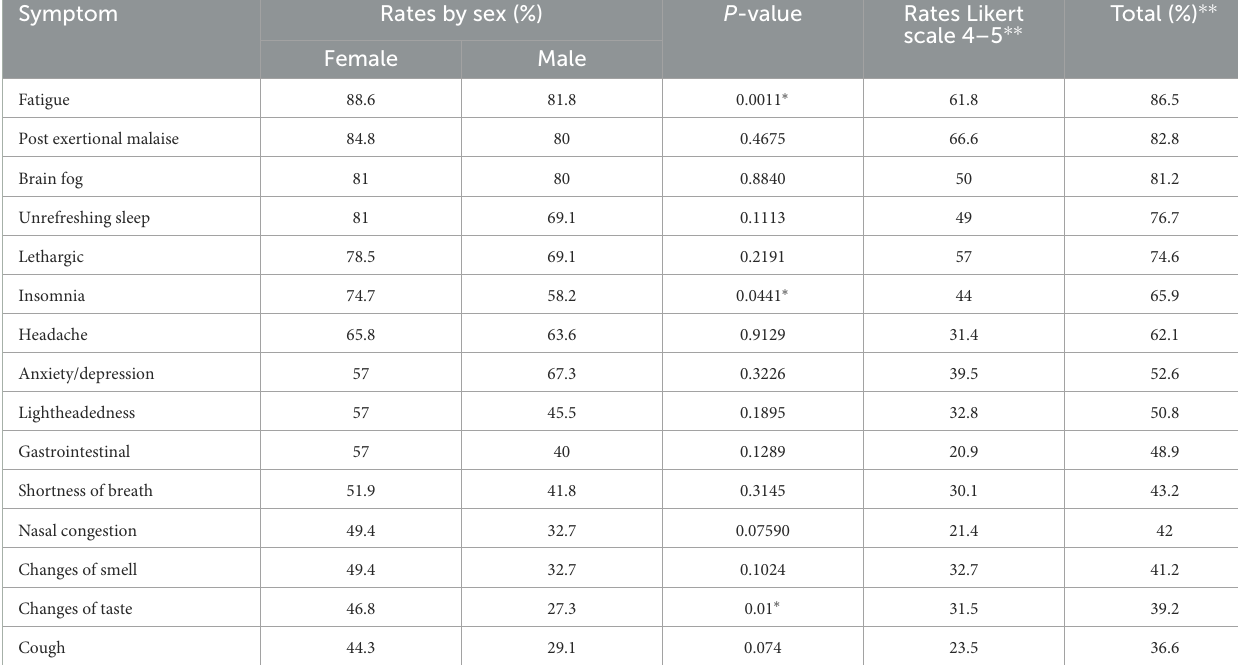
TABLE 2 Distribution rates of the most common 15 symptoms in PASC patients by sex and severity.